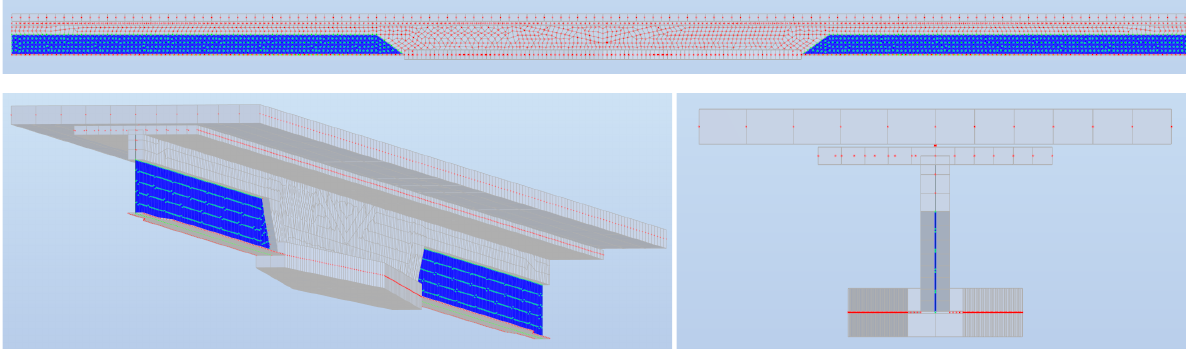
Figure 13: Side view, 3d view and cross section of a finite element model of the considered beam (steel web highlighted in